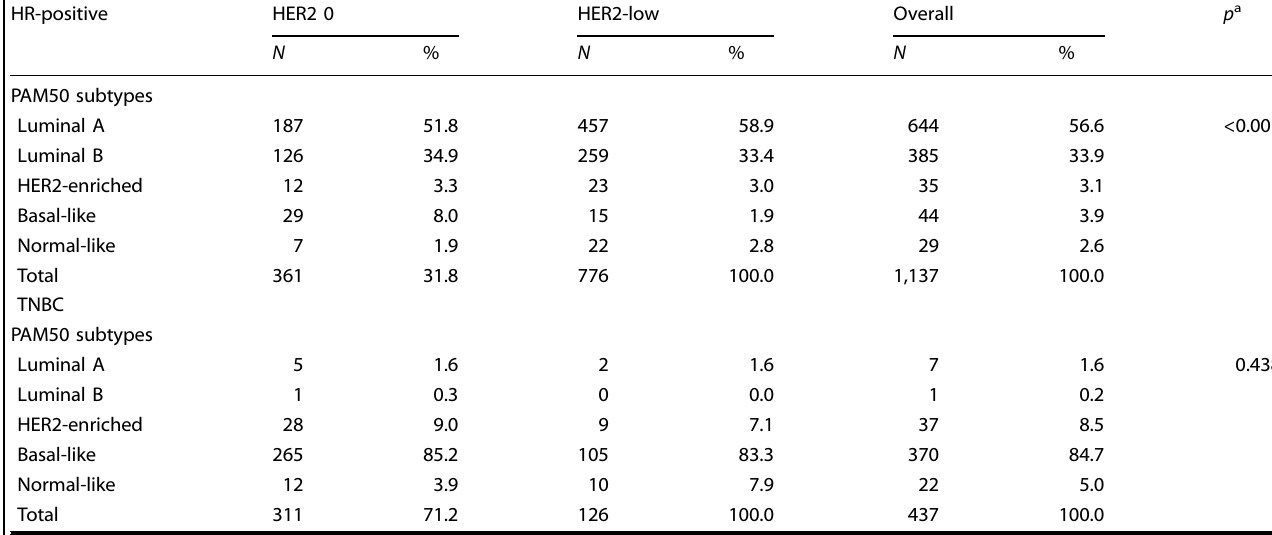
Table 2. PAM50 intrinsic subtypes distribution within HR-positive and TN tumors according to HER2 status. HR-positive